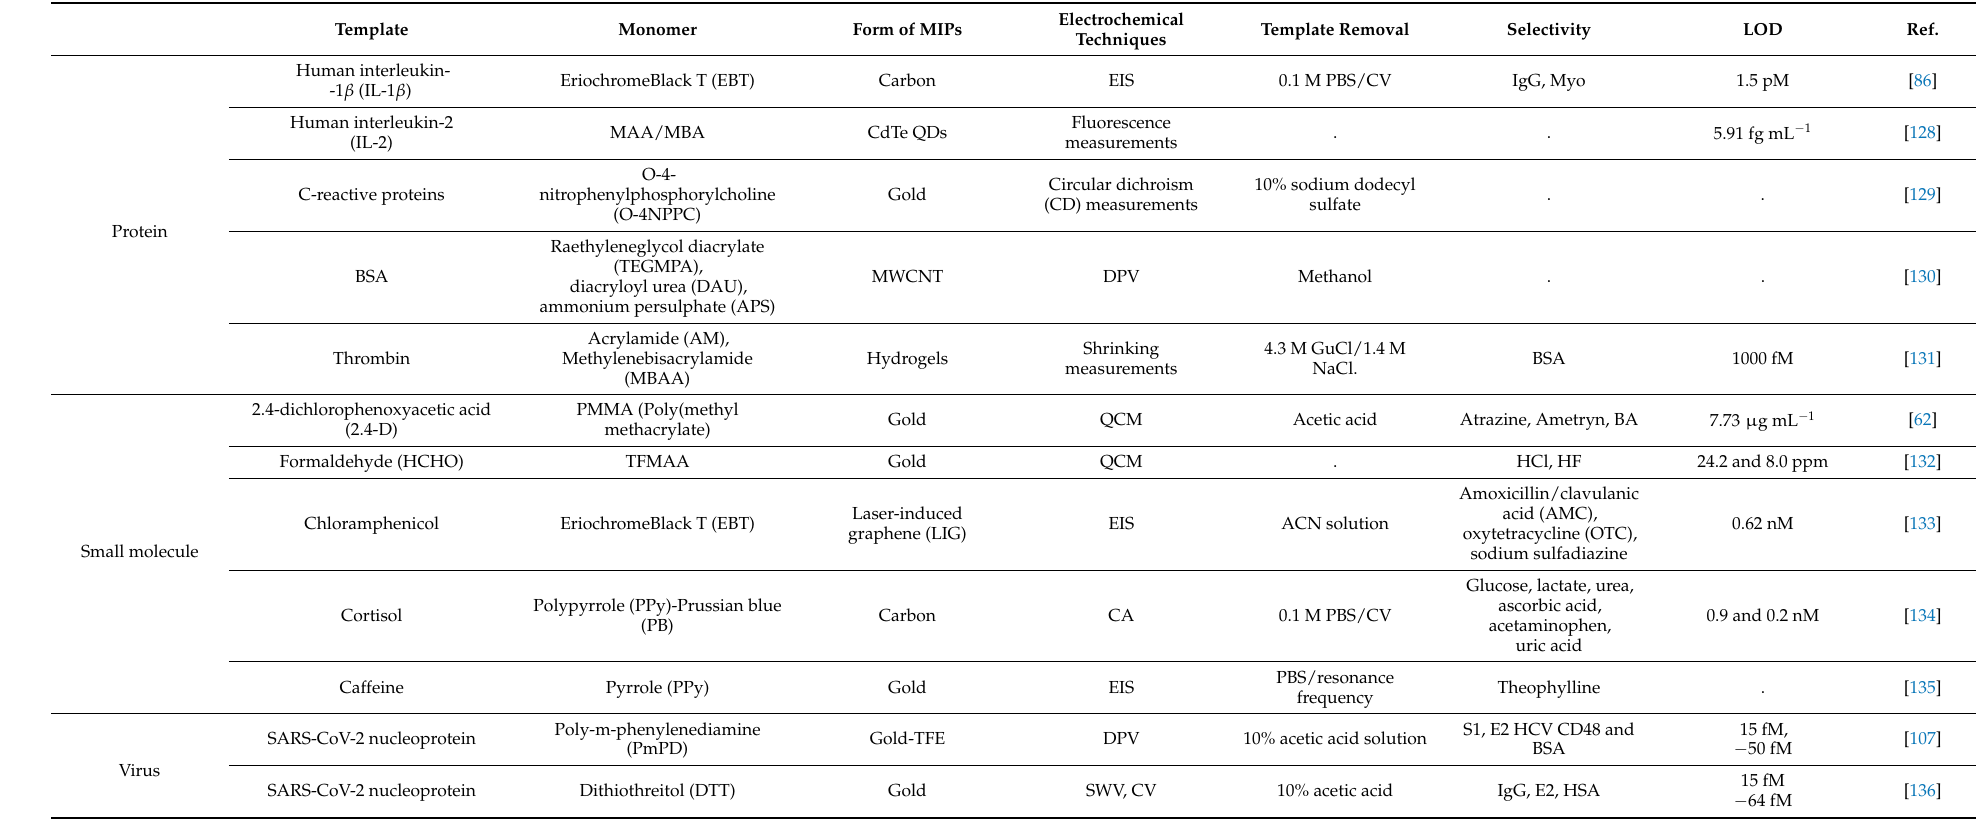
Table 1. Summary of versatile approaches for detecting biomolecules using MIP-based